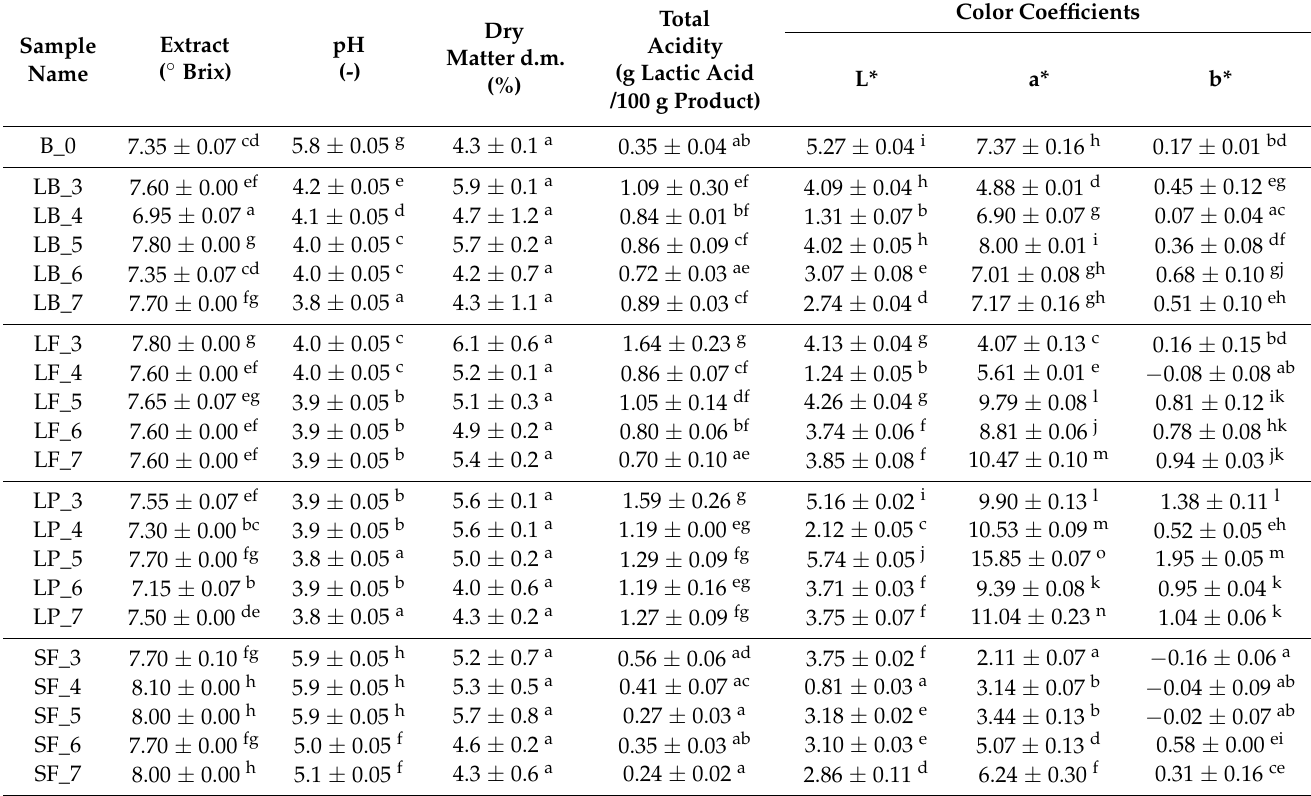
Table 1. Physicochemical properties of fermented beetroot